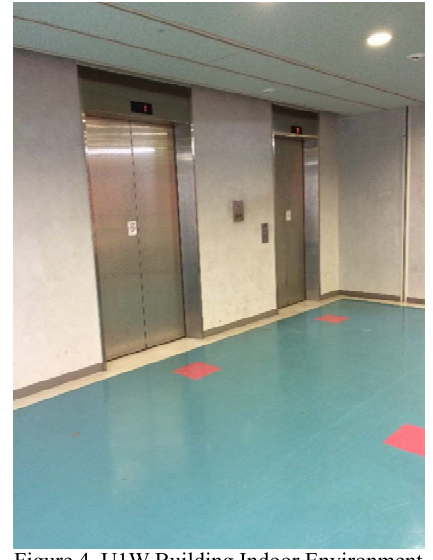
Figure 4. U1W Building Indoor Environment